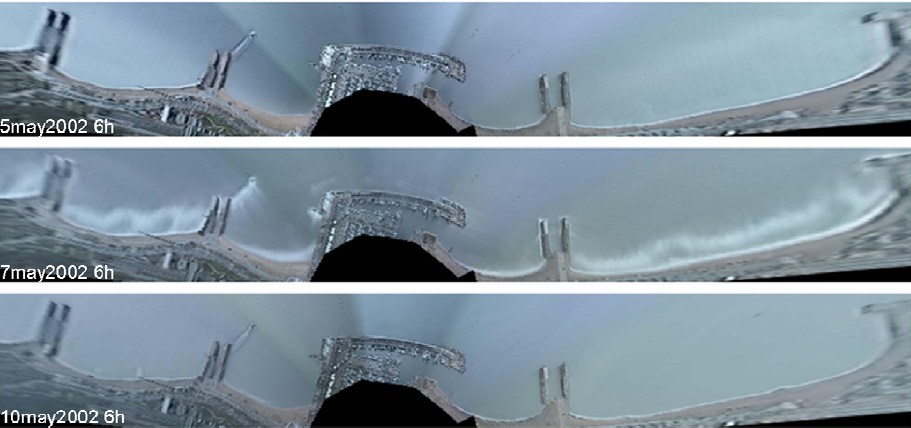
Fig. 6. Planviews showing the effect of the eastern storm event occurring on early May 2002. Two megacusps were developed at La Barceloneta beach and crescentic bar features at the Bogatell